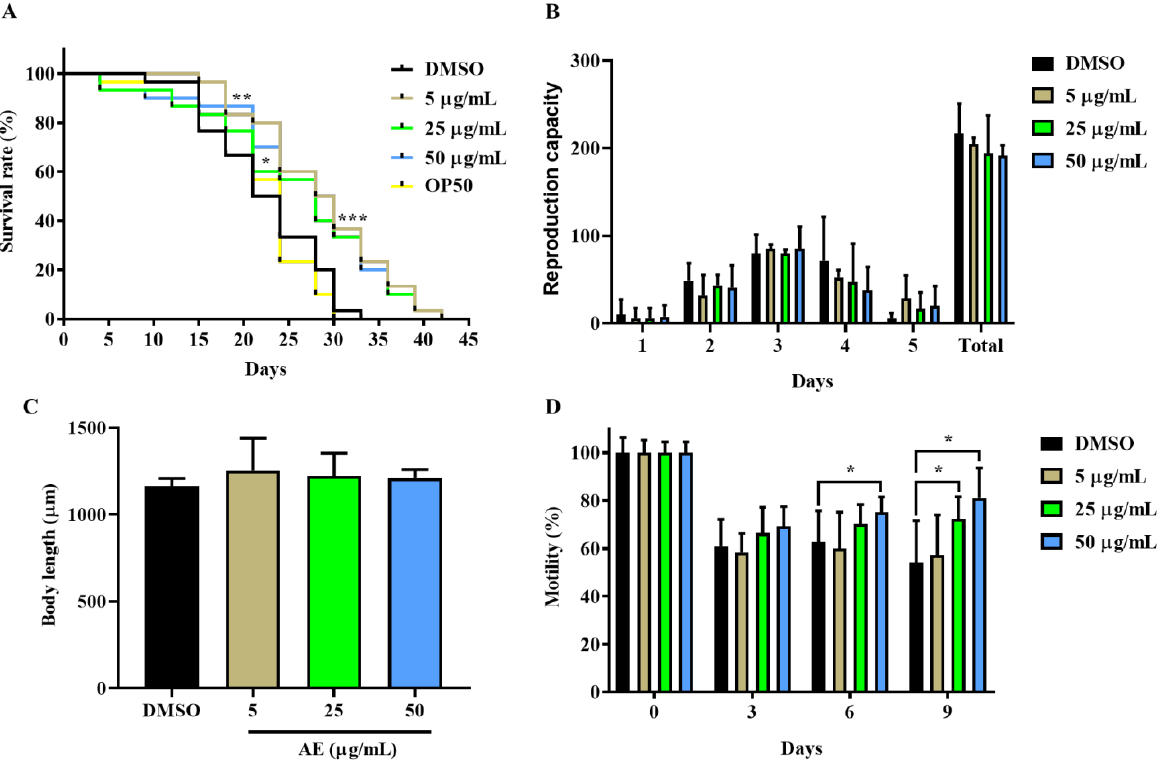
Figure 1. Effect of AE on lifespan and health span of wild type C. elegans . Worms were cultured at 20 °C on NGM-OP50 plates containing DMSO or AE (5, 25 and 50 µg/mL). ( A ) Lifespan of worms treated with or without AE ( n = 30 worms/group). Statistical differences compared to control (DMSO) were considered significant at * p < 0.05, ** p < 0.01, *** p < 0.005 by log-rank test. ( B ) Reproduction ability of AE-treated and non-treated worms. The number of worms per group was one and the data of three independent experiments were represented. n = 3. ( C ) Body length determination of worms fed with or without AE for 96 h ( n = 20 worms/group). ( D ) Motility of AE-treated and non-treated worms ( n = 10 worms/group). Statistical differences compared to control (DMSO) were considered significant at * p < 0.05 by two-way ANOVA. Data were represented by mean ± SD. Experiments were performed in triplicate determinations.